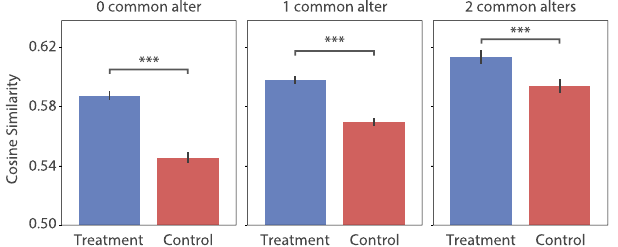
Figure 3. Inter-ego semantic similarities under various conditions. Cosine similarities between the idea-sets of egos-pairs are shown across three sub-groups: ego-pairs who share 0, 1 and 2 common alters between them. With the increase in the number of common alters (i.e., increase in stimuli similarity), the inter-ego semantic similarity typically increases. Importantly, the semantic similarities are significantly higher in the treatment condition compared to the control condition in all three sub-groups. Whiskers denote 95% C.I. *** P < 0.0001 , corrected for multiple comparisons.